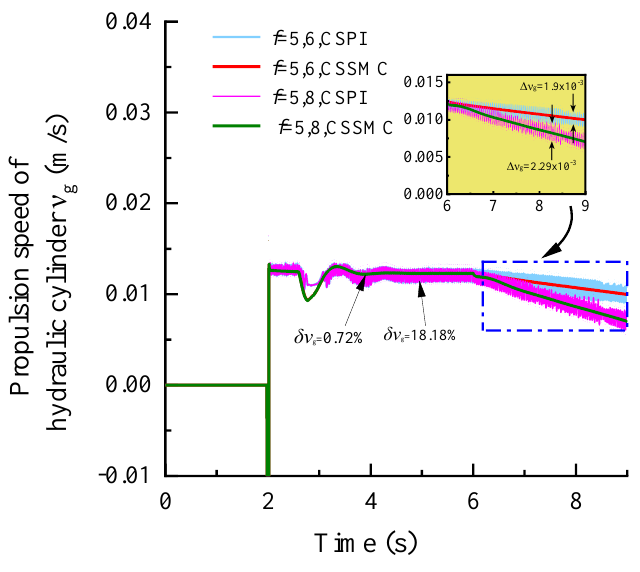
Figure 8. Variation curve of the hydraulic cylinder speed based on the CSPI and CSSMC. The speed pulsation coefficient of the hydraulic motor is defined as δ nm and the velocity pulsation coefficient of hydraulic cylinder is defined as δ ng